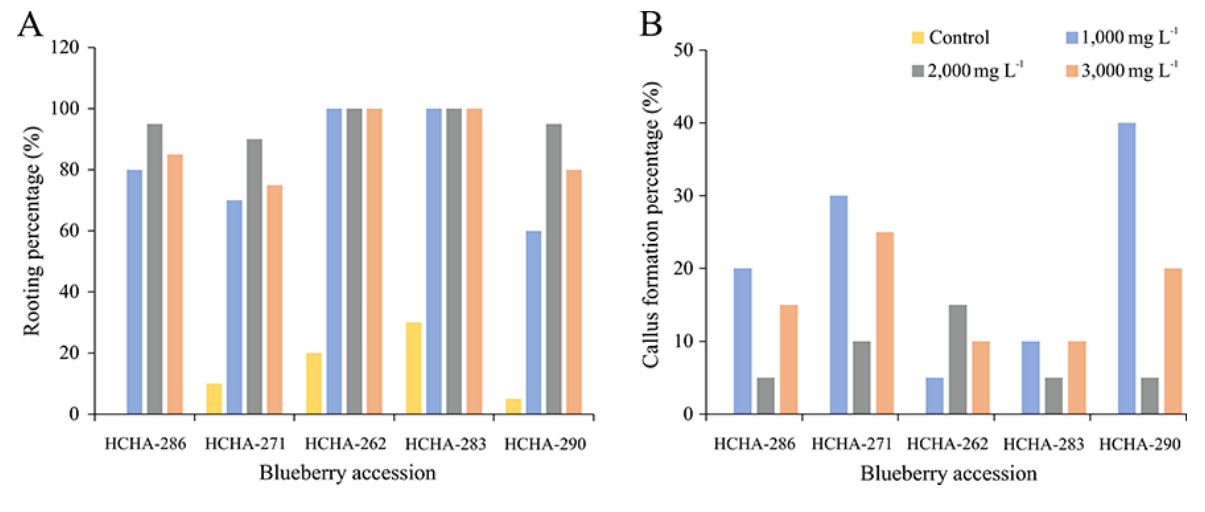
Figure 1 Effects of indole-3-butyric acid (IBA) concentration on the ( A ) rooting percentage and ( B ) callus formation percentage of cuttings of five wild blueberry